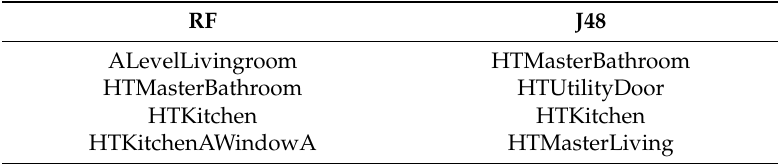
Table 11. Selected SH attributes that as a group predict indoor methanol in IAQ 1 . RF J48